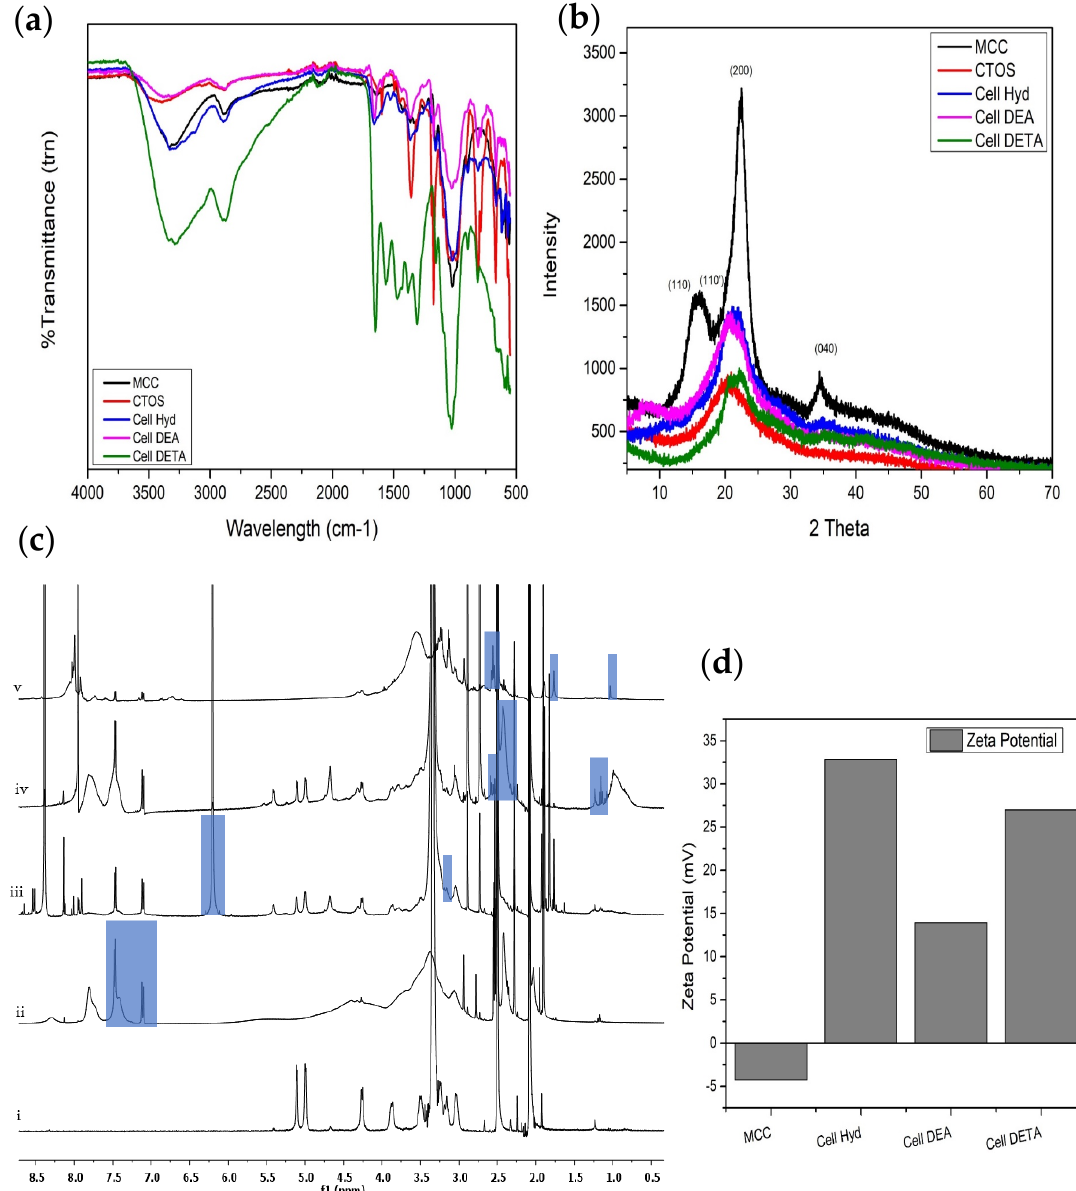
Figure 1. Characterization of cellulose and cellulose amine derivatives: ( a ) FTIR; ( b ) XRD; ( c ) 1 HNMR: (i) MCC, (ii) Tosylated Cellulose (CTOS), (iii) Cell Hyd, (iv) Cell DEA, (v) Cell DETA; ( d ) Zeta potential measurement.